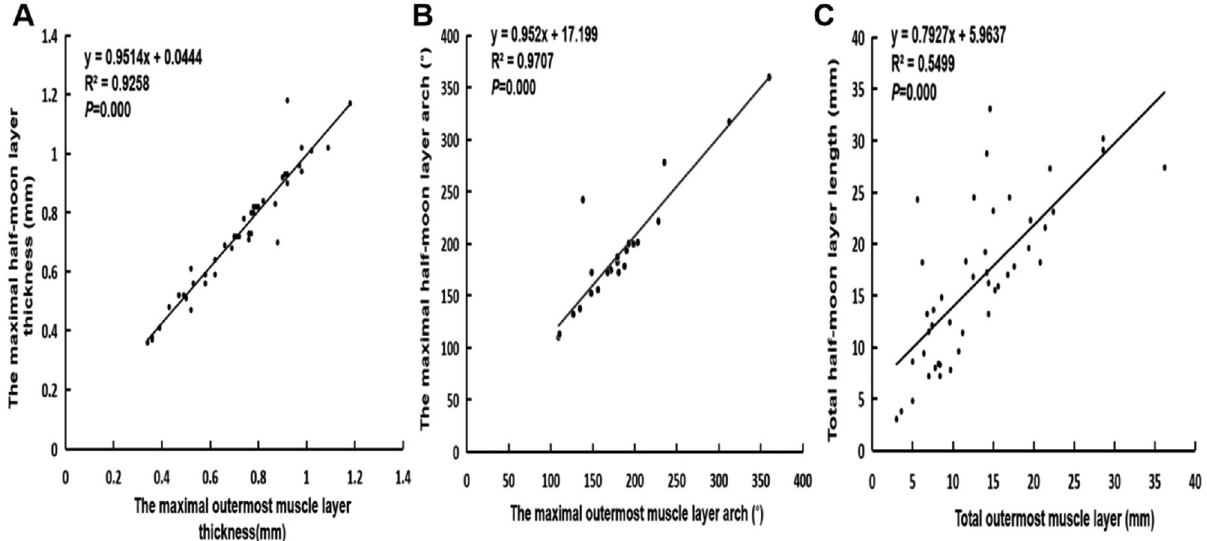
Figure 4. The relation of IVUS and OCT for evaluating the MB characteristics. ( A ) The relation of the maximal visible outermost muscle layer’s thickness with the maximal half-moon layer’s thickness. ( B ) The relation of the maximal visible outermost muscle layer’s arch with the maximal half-moon layer’s arch. ( C ) The relation of total visible outermost muscle layer’s length with total half-moon layer’s